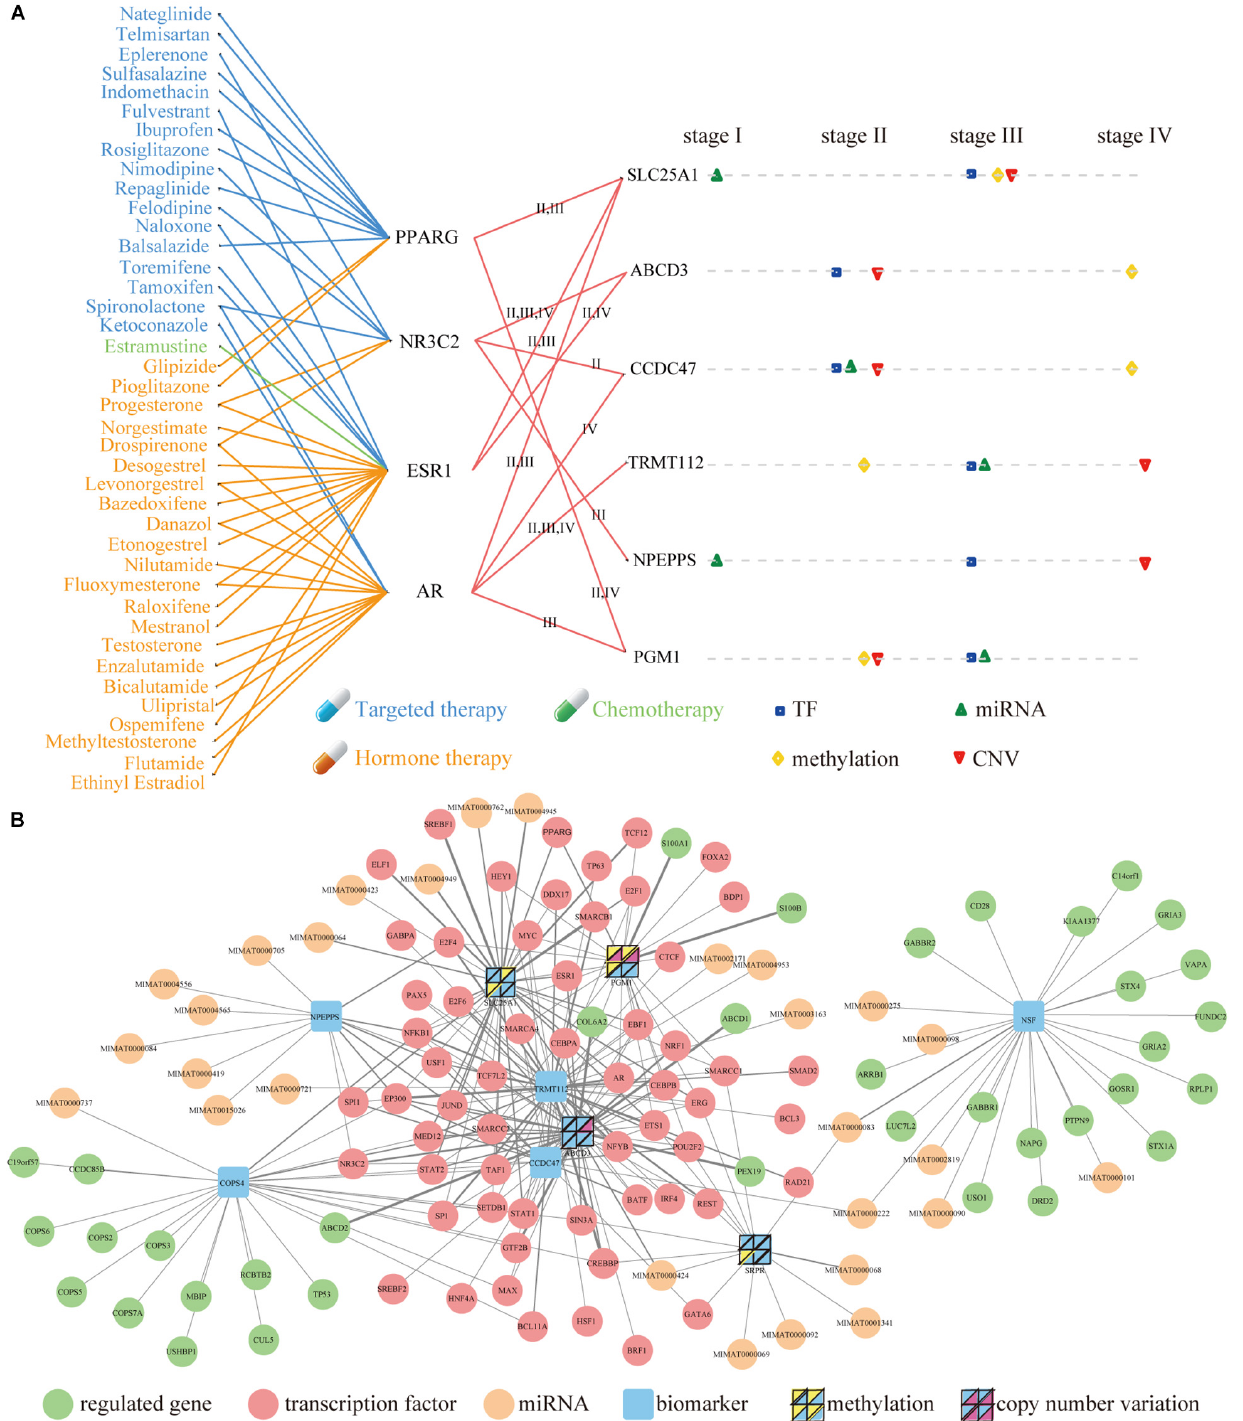
Frontiers in Genetics |